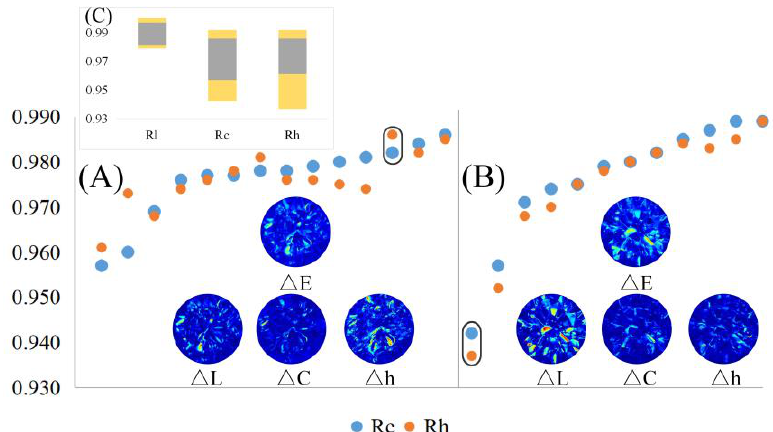
Figure 5. Pearson correlation coe ffi cients of R e with R l , R c , and R h . ( A ) Pearson correlation coe ffi cients of R e with R c , and R h when the results by the entropy method were one level higher than the results by the naked eye and the color di ff erence image, lightness di ff erence image, chroma di ff erence image, and hue di ff erence image of Dia 0035 (within the gray frame). ( B ) Pearson correlation coe ffi cients of R e with R c and R h when the results by the entropy method were one level lower than the results by the naked eye and the color di ff erence image, lightness di ff erence image, chroma di ff erence image, and hue di ff erence image of Dia 1711 (inside the gray frame). ( C ) Pearson correlation coe ffi cients ranges of R e with R l , R c , and R h when the results by the entropy method were one level higher than the results by the naked